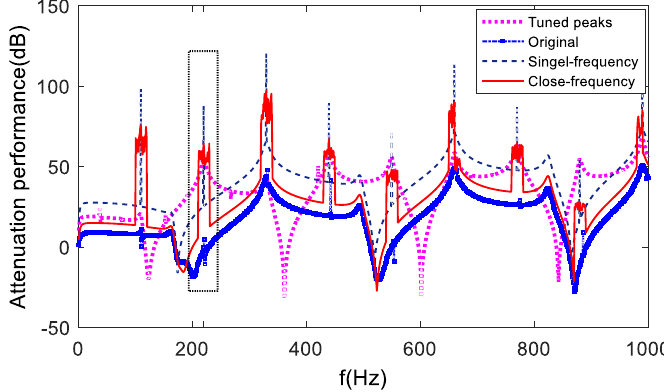
Figure 9. Attenuation effects after extending the performance around 220 Hz.